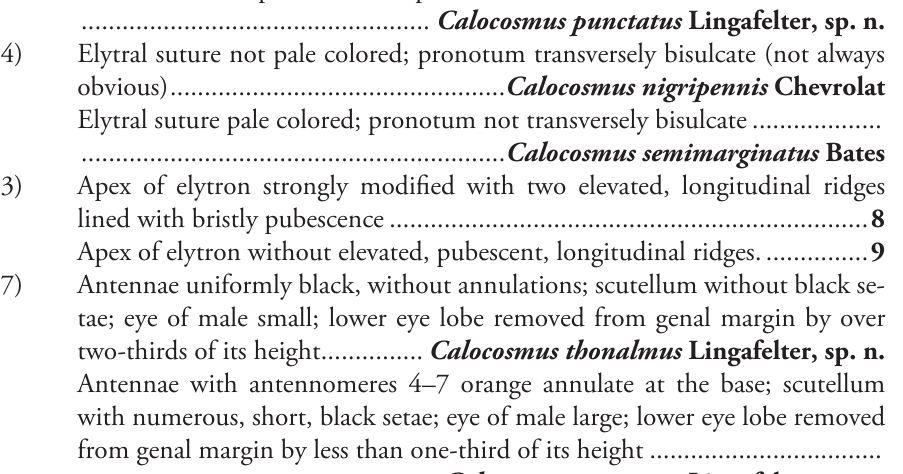
Elytral suture not pale colored; pronotum transversely bisulcate (not always – Elytral suture pale colored; pronotum not transversely bisulcate ................... 7(3) Apex of elytron strongly modified with two elevated, longitudinal ridges – Apex of elytron without elevated, pubescent, longitudinal ridges. ............... 9 8(7) Antennae uniformly black, without annulations; scutellum without black se- tae; eye of male small; lower eye lobe removed from genal margin by over two-thirds of its height ............... Calocosmus thonalmus Lingafelter, sp. n. – Antennae with antennomeres 4–7 orange annulate at the base; scutellum with numerous, short, black setae; eye of male large; lower eye lobe removed from genal margin by less than one-third of its height .................................. 9(7) Apical macula of elytron restricted to tip, very small, less than apical one- eighth; pronotum dorsally with three small, dark maculae (one at center, and one at each side of center), also a small dark macula laterally on each side; humerus with small, isolated macula ............. Calocosmus magnificus Fisher – Apical fourth to half of elytron with large, black or purplish macula; prono- tum either without dark macula, or macula restricted to middle; humerus without isolated macula (if dark, part of a larger maculate region extending over more of elytral base than just humerus) ............................................. 10 10(9) Apex of elytron with dark macula mostly shiny, iridescent, and glabrous ...... – Apex of elytron with dark macula mostly pubescent, not shiny, with or with- 11(10) Humerus not prominent (not projecting anterolaterally; usually without glabrous region; elytron approximately parallel-sided); pronotum with weak lateral and dorsal swelling at middle; relatively delicate species (specimens < 4 mm wide); pronounced hair patches present on posteromedial part of – Humerus prominent (projecting anterolaterally; usually with small glabrous region at apex; elytron often noticeably wider at base than apex); pronotum with pronounced lateral and dorsal swelling at middle; robust species (most specimens, particularly females, > 4 mm broad); conspicuous hair patches absent on posteromedial part of metasternum in males ............................. 13 12(11) Elytral base, including scutellum, nearly completely dark; legs nearly com- pletely dark reddish-brown to black; apical black macula of elytron